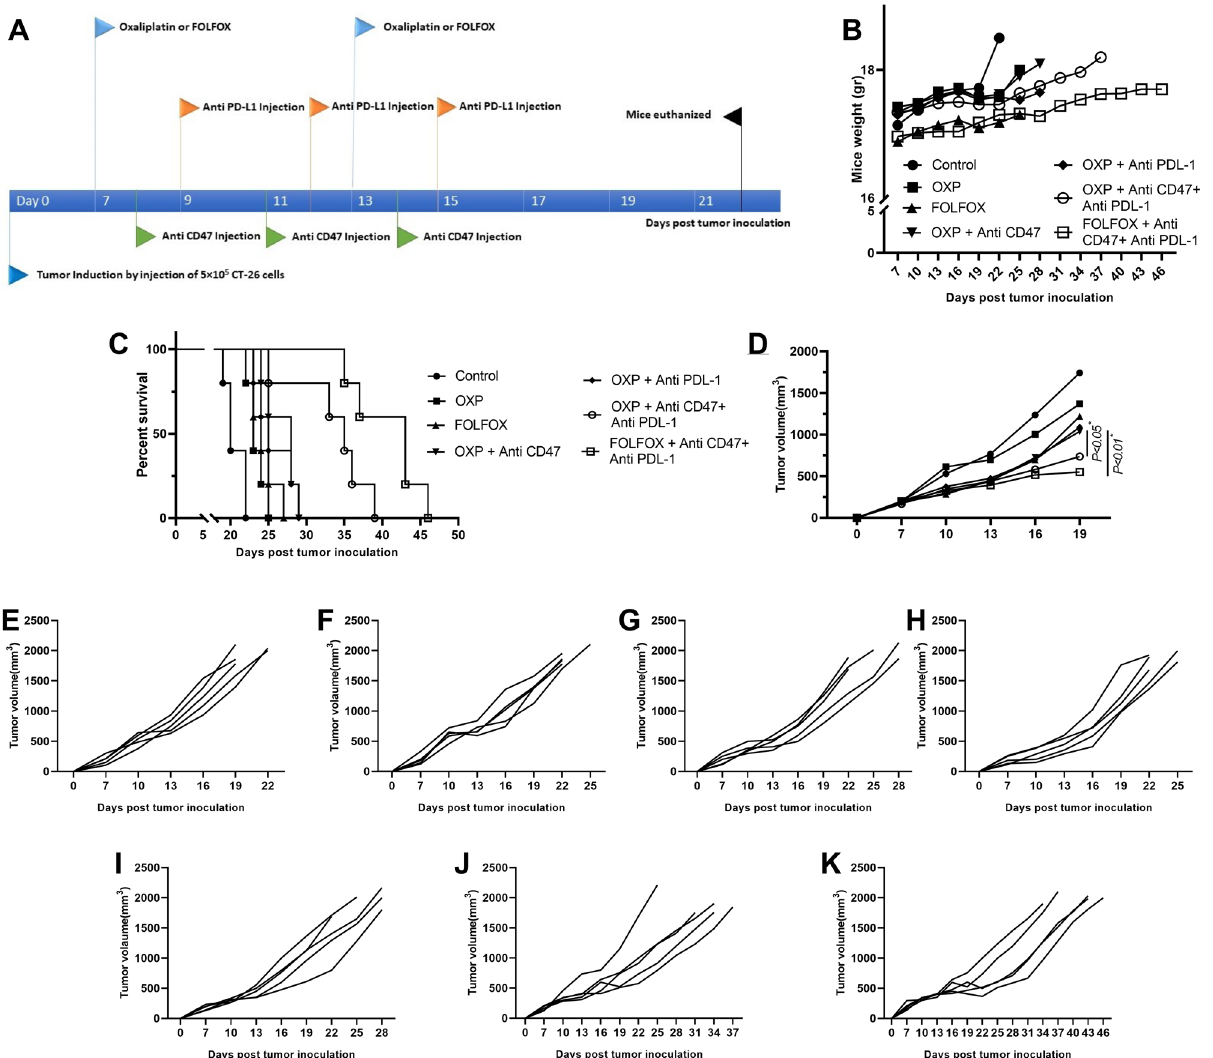
Figure 3. The combination of FOLFOX, anti-CD47, and anti-PD-L1 showed the best potential in the syngenic CT-26 tumor model. ( A ) Detailed schedule for the injection of therapeutic agents. ( B ) Changes in the average body weight (g) of tumor-bearing mice in control and different treated groups. ( C ) Survival of the mice in days, with median survival shown. Significances were determined by log-rank (MantelCox) test; n = 5 mice per group. ( D ) BALB/c mice bearing with CT-26 tumor were injected with corresponding therapeutic regimen according to the indicated schedule. Tumor volume was measured at the indicated time points. ( E – K ) tumor volume of each mice in all therapeutic groups.